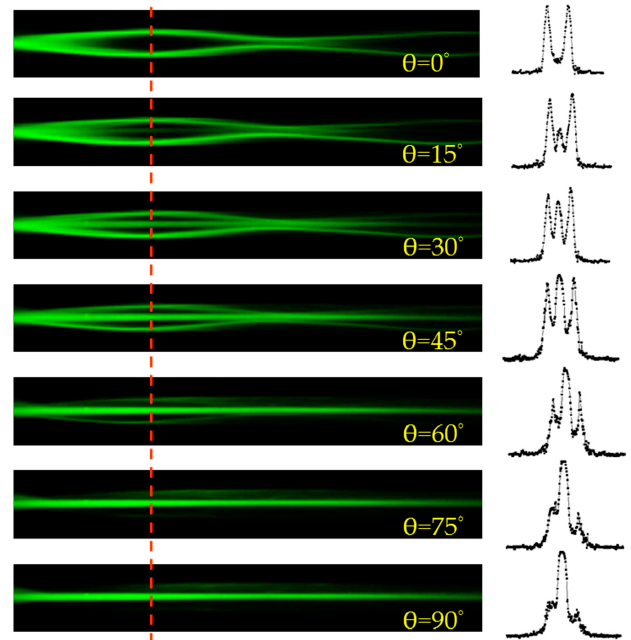
Figure 8. The polarization dependence of laser beam coupling into electrode channels with the applied voltage of 2.1 V. The intensity distributions of the laser beam at the position of z = 0.8 mm is also